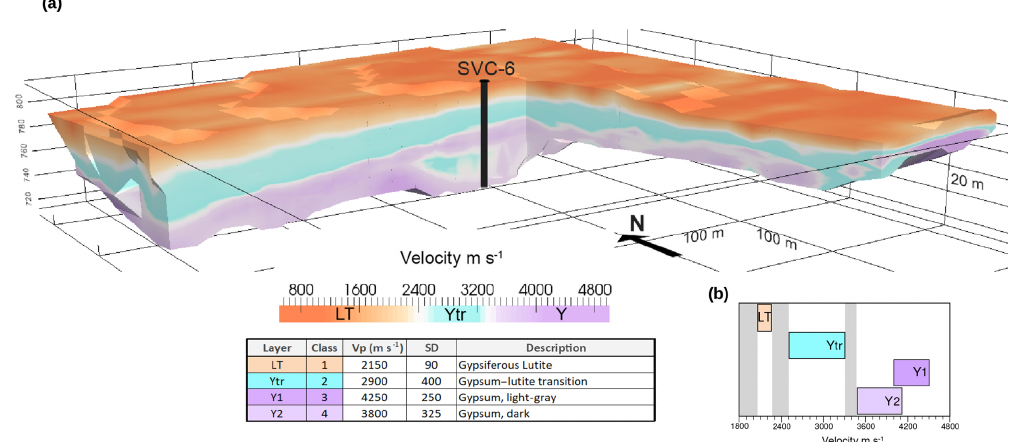
Figure 7. (a) 3-D seismic velocity model grid of the shallow subsurface color coded according to the interpreted lithologies derived from Fig. 6. Four different units have been identified: LT, lutites; Ytr, the gypsum–lutite transition layer; and Y1 and Y2, gypsum units. (b) Graph showing the velocity ranges established and the gaps between them. These gaps correspond to seismic velocities that do not have lithologies